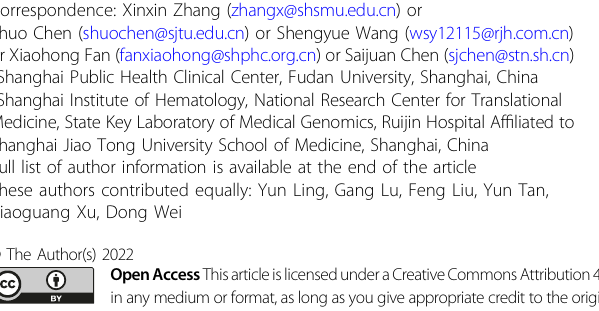
(Fig. 1c – f; Supplementary Fig. S2) — which characterize BA.2.2.1, a new subvariant of the Omicron BA.2.2 family. To determine whether BA.2.2.1 originated from Shanghai, we blasted our BA.2.2.1 sequences against SARS-CoV-2 genomes in the GSIAID database (published as of June 13th, 2022), and found 38 cases of BA.2.2.1. Of them, 6 were reported before the onset of the Shanghai outbreak at